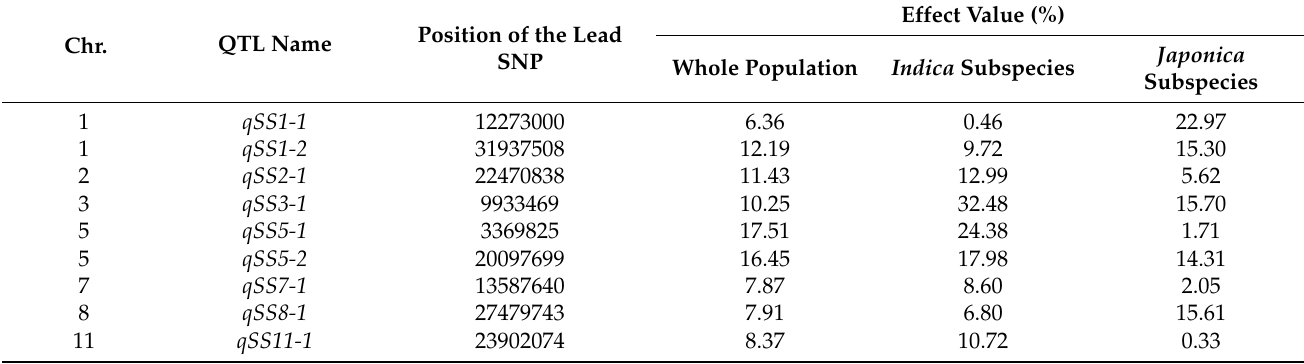
Table 2. The lead SNP effect value in the whole population, indica subspecies, and japonica subspecies, respectively.